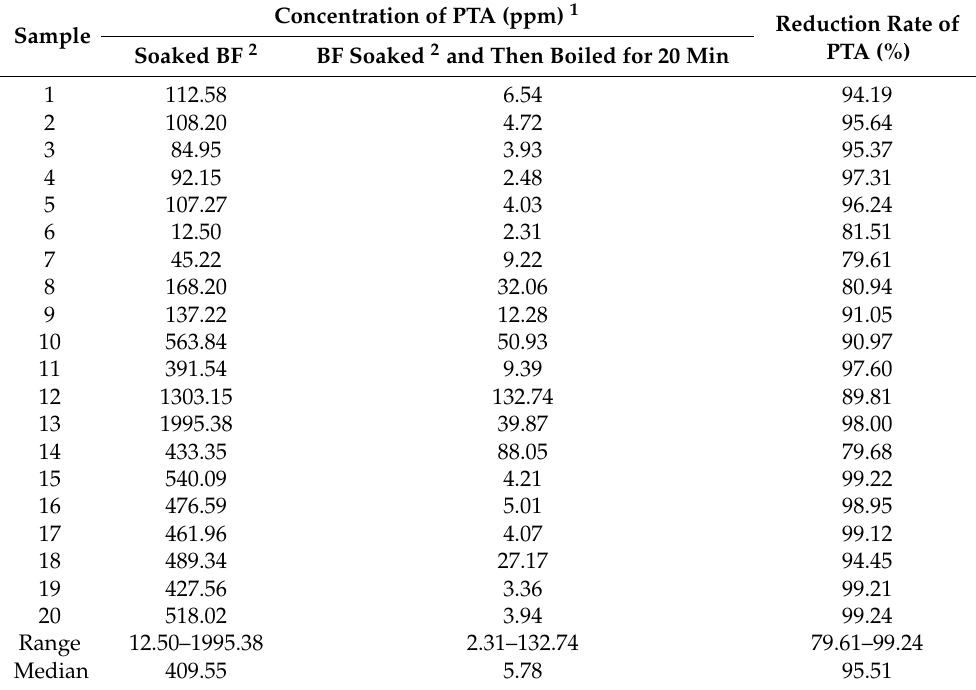
Table 2. Analysis of the concentration of PTA in BF after boiling for 20